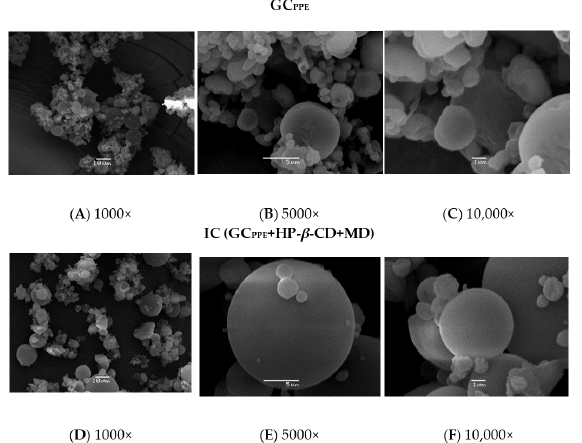
Figure 1. Scanning electron microscopy micrographs of the GC PPE ( A – C ) and IC (GC PPE +HP- β - CD+MD) ( D – F ) at different magnifications.